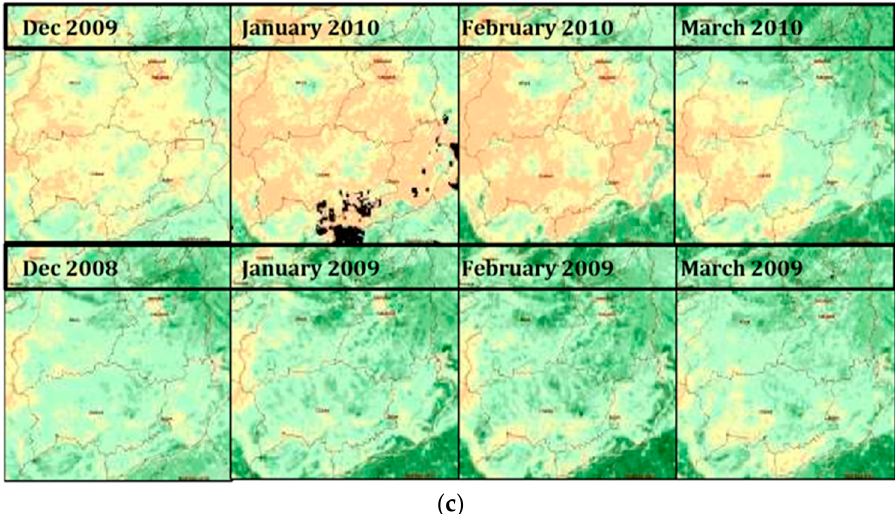
Figure 2. Images of remote sensing in crop production: Localization of Agua Fria experimental station trial in the state of Puebla Mexico ( a ) A, color-infrared image (550, 660, 790 nm) of maize hybrids in the experimental trials for phenotyping of Tar Spot Complex Resistance under fungicide treatment ( a ) A1 and non-fungicide treatment ( a ) A2, image data extracted from two polygons of two central rows in each plot ( a ) B, SPOT-5 satellite for crops acreage estimate during peak growth of crops ( b ), and monthly SPOT NDVI crop phenology behavior in a rainfed area of Punjab ( c ).